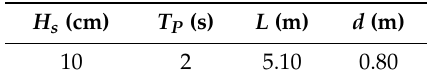
Table 1. Experimental parameters of the analysed regular